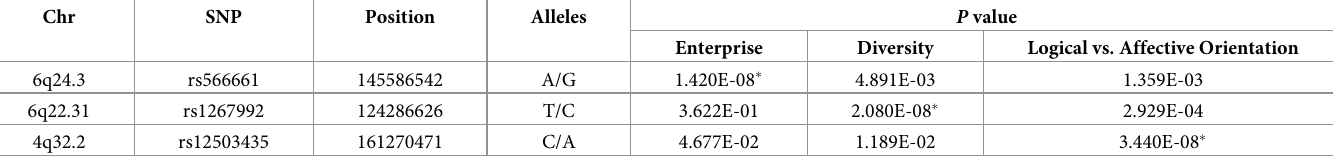
Chr, chromosome; SNP, single nucleotide polymorphism � The p value thresholds for statistical significance: 5 × 10 − 8